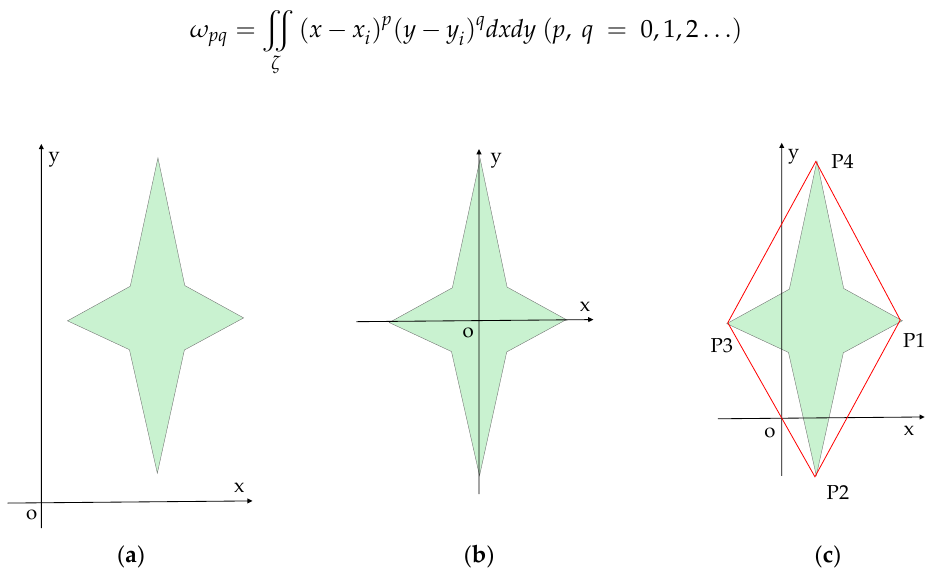
Figure 4. Transformation method of center moments and local moments: ( a ) Original position of the polygon, ( b ) moving the origin of coordinates to the centroid of the polygon; and ( c ) the red polyline is the boundary of convex hull, moving the origin of coordinates to the point on the boundary of convex hull.